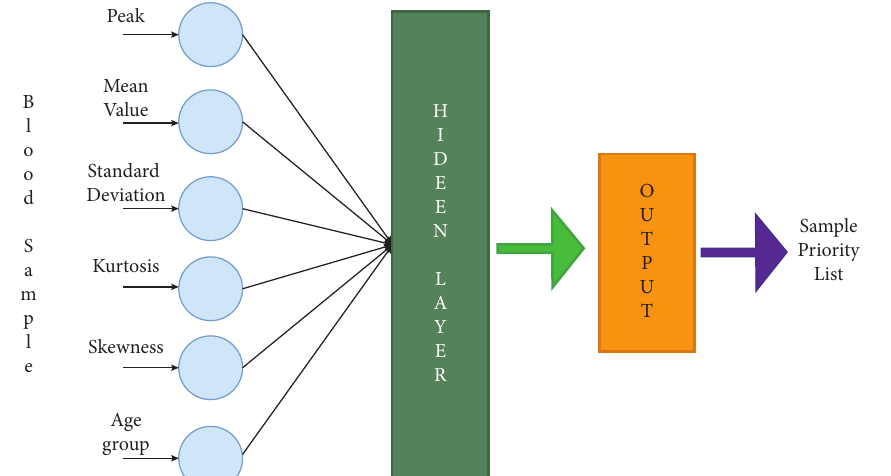
Figure 1: ANN technique for sample priority for better